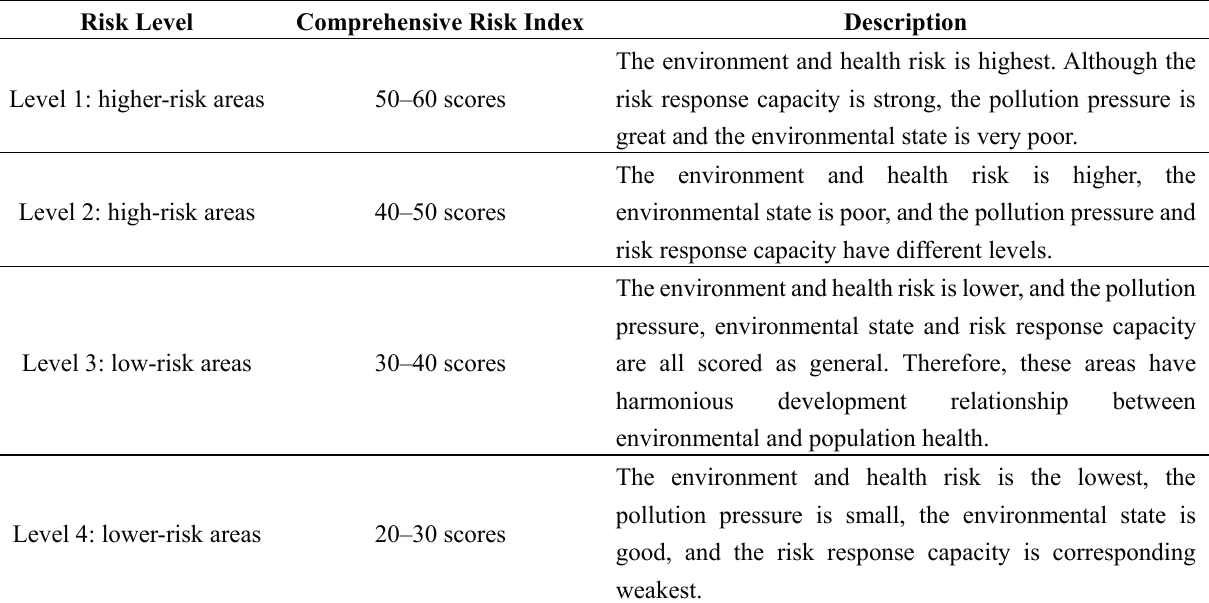
Table 2. The division criterion for comprehensive risk of environment and